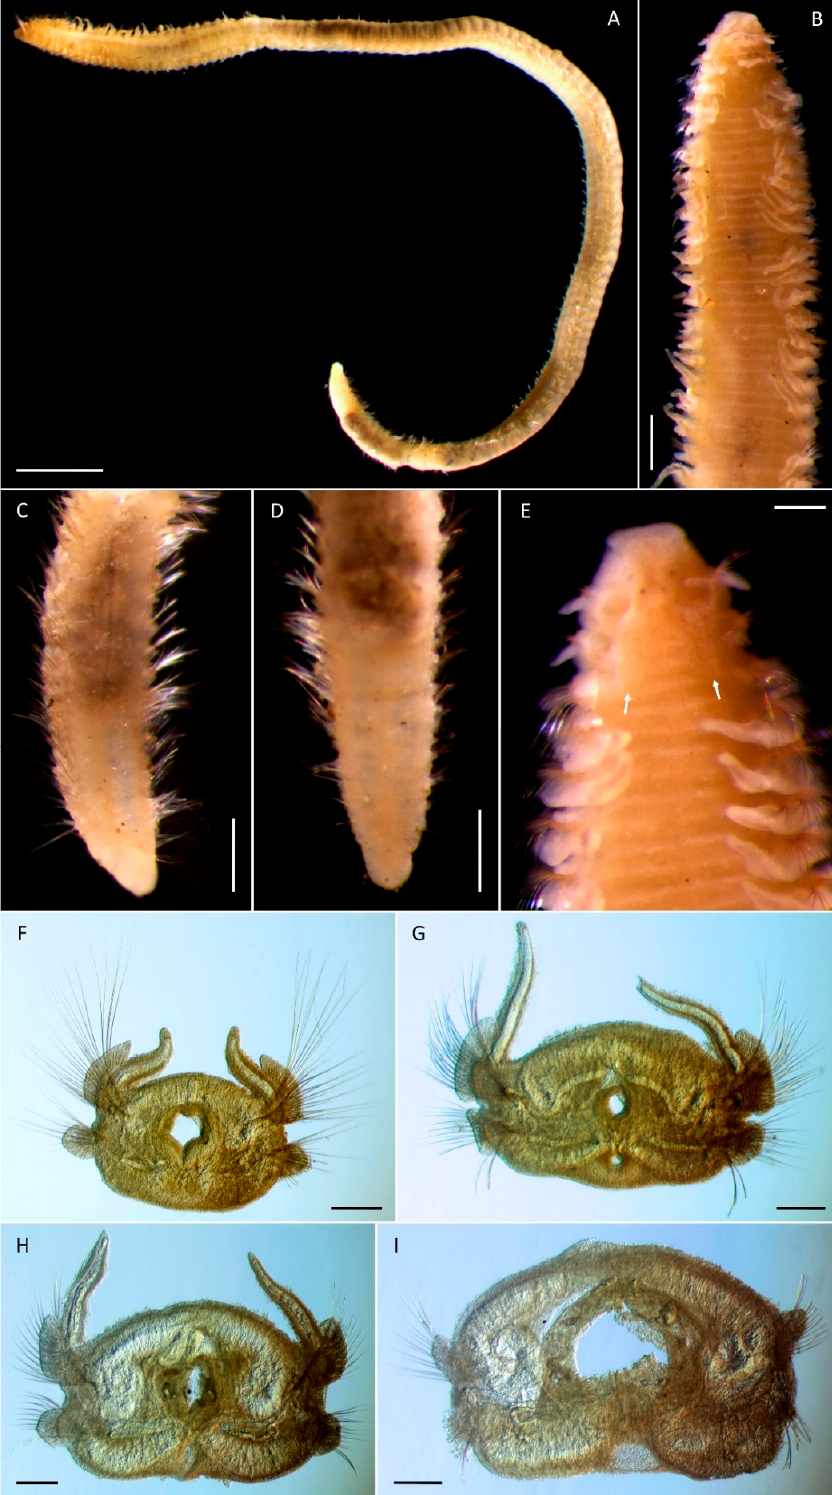
Figure 2. Marenzelleria neglecta collected in the Sakhalin Lagoon, Black Sea. ( A )—Complete specimen; ( B )—anterior end with no palps; ( C , D )—posterior end with pygidium, ventral, and dorsal view; ( E )—anterior end, dorsal view showing the ends of nuchal organs (arrows) (first three pairs of branchiae were removed); ( F – I )—transverse section showing anterior views of parapodia from chaetigers 3, 10, 25, and 40, respectively. Scale bars: ( A )—2 mm; ( B – D )—500 µm; ( E – I )—200 µm.